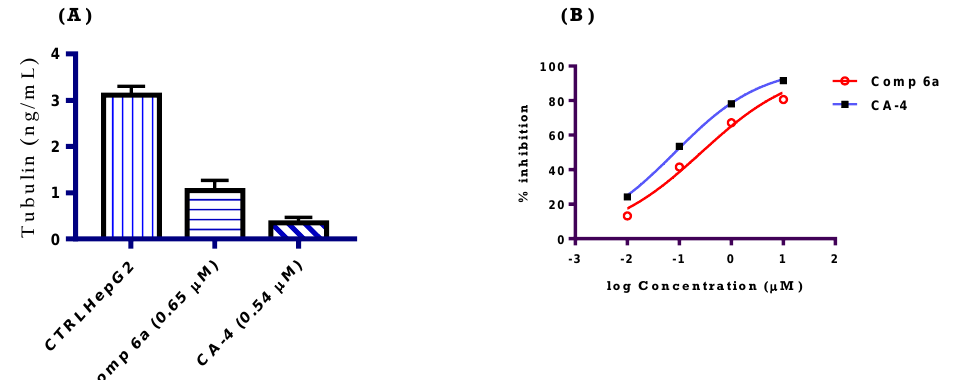
Figure 3. ( A ) Tubulin polymerization inhibition activity induced by compound 6a compared with no treatment control cells using ELISA assay for β -tubulin. ( B ) Dose response curve for in vitro β -tubulin inhibitory activity of tetraamide 6a and CA-4 against tubulin.